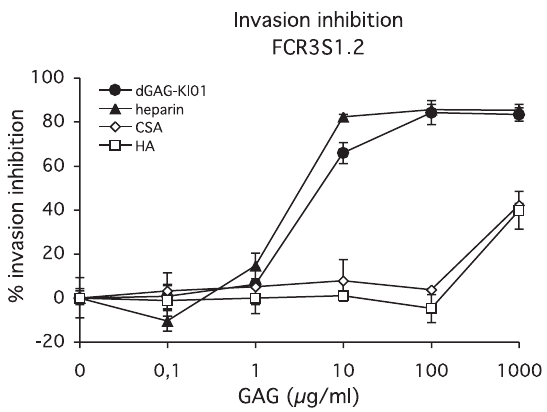
Figure 4. Effects of Different GAGs on Reinvasion of P. falciparum Merozoites (FCR3S1.2) into Fresh Erythrocytes In Vitro Parasite culture at throphozoite stage ( ’ 25 h of development) at a 0.4% parasitemia and a 2% hematocrit were incubated with increasing concentrations of dGAG-KI01, heparin, CSA, or HA for 24–30 h at 37 8 C. Parasitemias were estimated using FACS counting with a minimum of 50,000 cells per sample. DOI: 10.1371/journal.ppat.0020100.g004